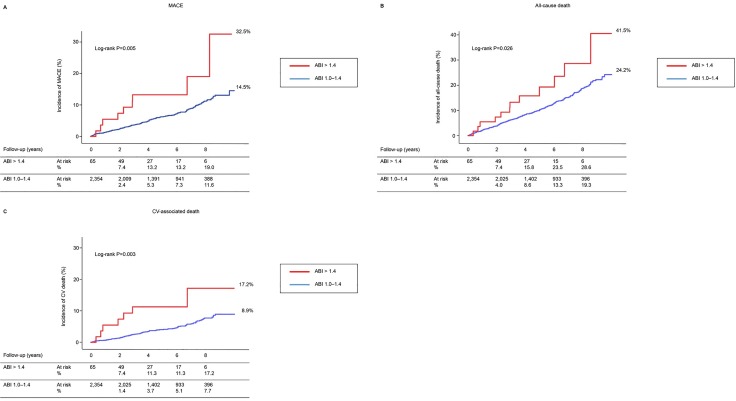
Kaplan-Meier analysis for (A) major adverse cardiovascular (CV) events (MACE) (CV-associated death, myocardial infarction, and stroke), (B) all-cause death, (C) CV-associated death, according to the ankle brachial index (ABI) categories.